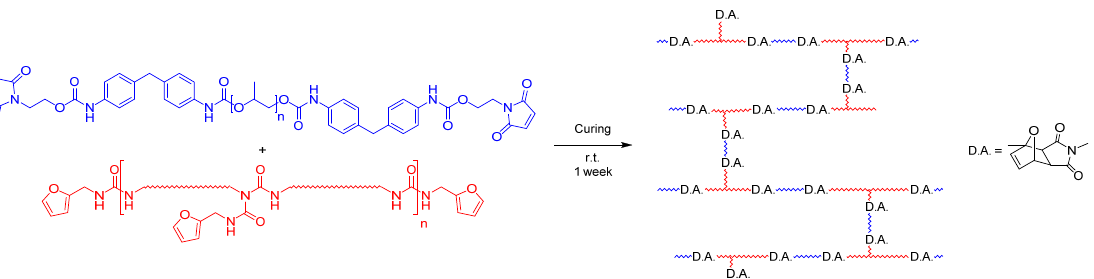
Figure 4. Crosslinking reaction of the two adhesive components during the curing process.